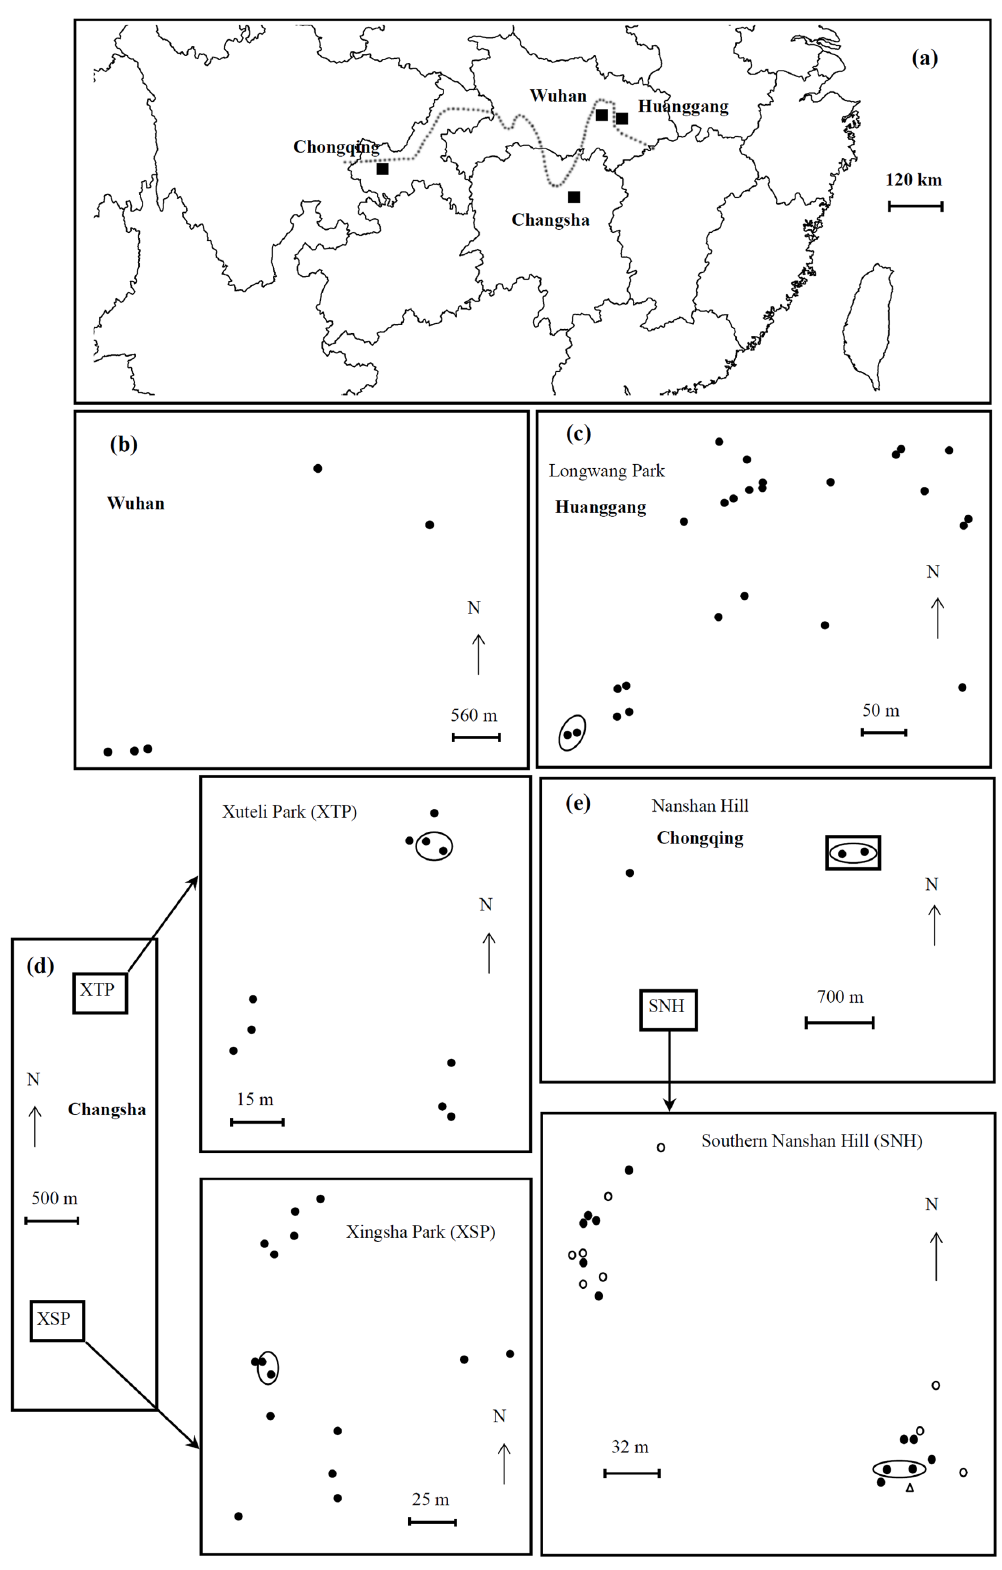
Figure 1. Map of the sample locations for the studies of population structure and reproductive mode. (a) Overview over the locations of the cities in China where samples were obtained from (Huanggang, Changsha and Chongqing and Wuhan). (b) Sample sites of entire nests including neotenics from Wuhan City, Hubei Province. (c) Sample sites of workers from Longwang Park,Huanggang City, Hubei Province. (d) Sample sites of workers from Xuteli Park and Xingsha Park, Changsha City, Hunan Province. (e) Sample sites of workers from Nanshan Hill, Nanan District, Chongqing